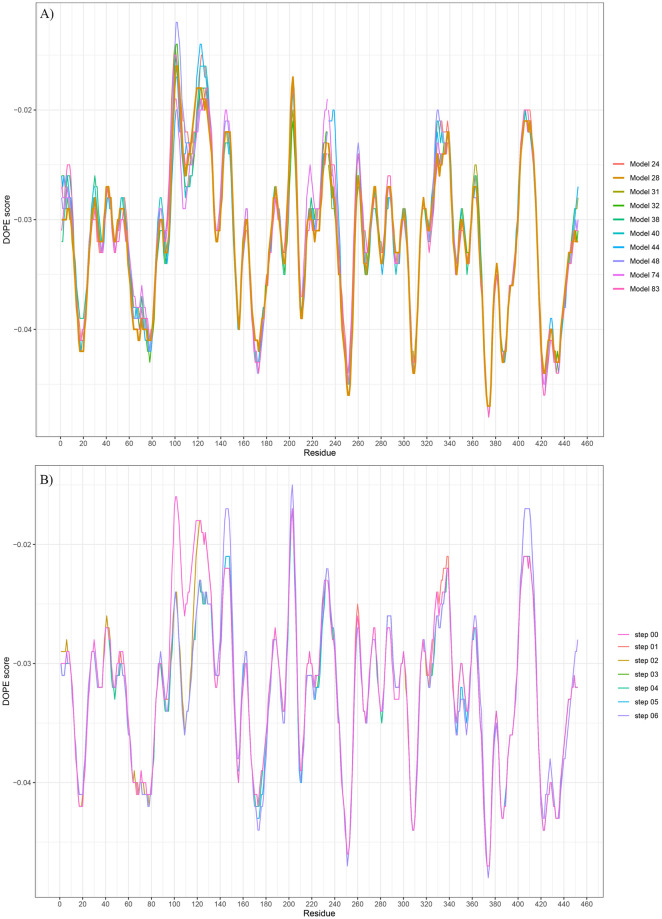
Plots of energy profiles of the Fab model through A) the multiple-template process and B) the ab-initio loop refinement method.The modeling and energy profiles were calculated using the MODELLER v9.21 tool.